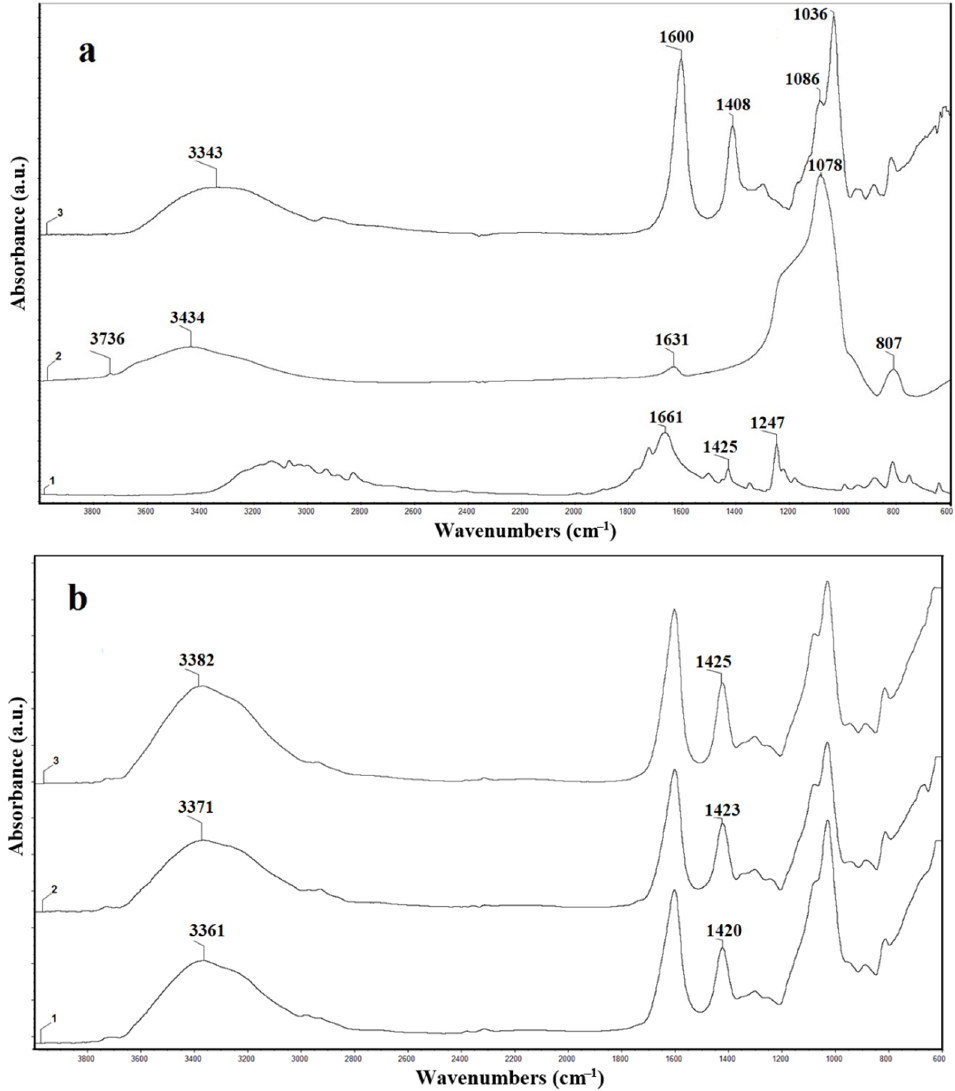
Figure 3. FTIR spectra of: ( a ): 1- 5-FU, 2-PCHs, 3- NaAlg; ( b ): 1- NaAlg- 5-FU-PCHs 1 wt%, 2-